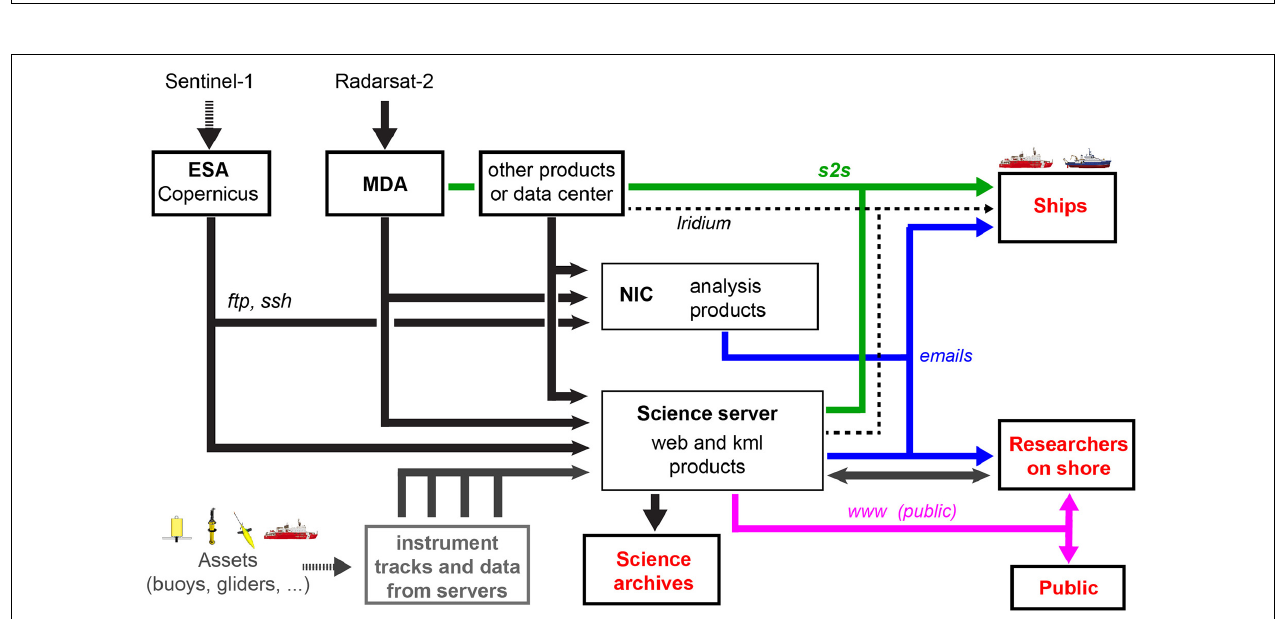
FIGURE 4 | Block diagram of the information sharing during the SODA field campaigns. Data and product providers (black boxes) provide information to users (red). The system and its connection pathways (arrows) are described in detail in the text.